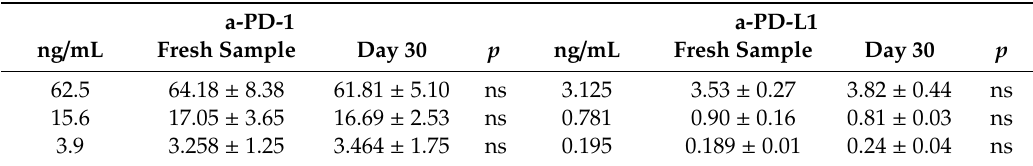
Table 5. Stability of antibody in plasma samples kept at 4 ◦ C for one month. (ns: non-statistically significant di ff erences).